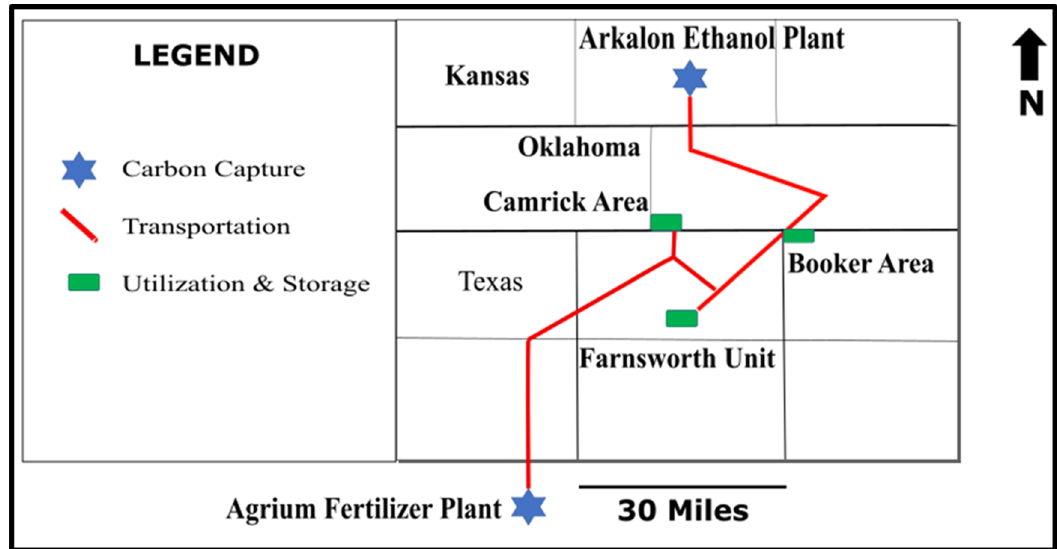
Figure 1. Location map of the SWP study area at Farnsworth, Texas and anthropogenic CO2 sources.